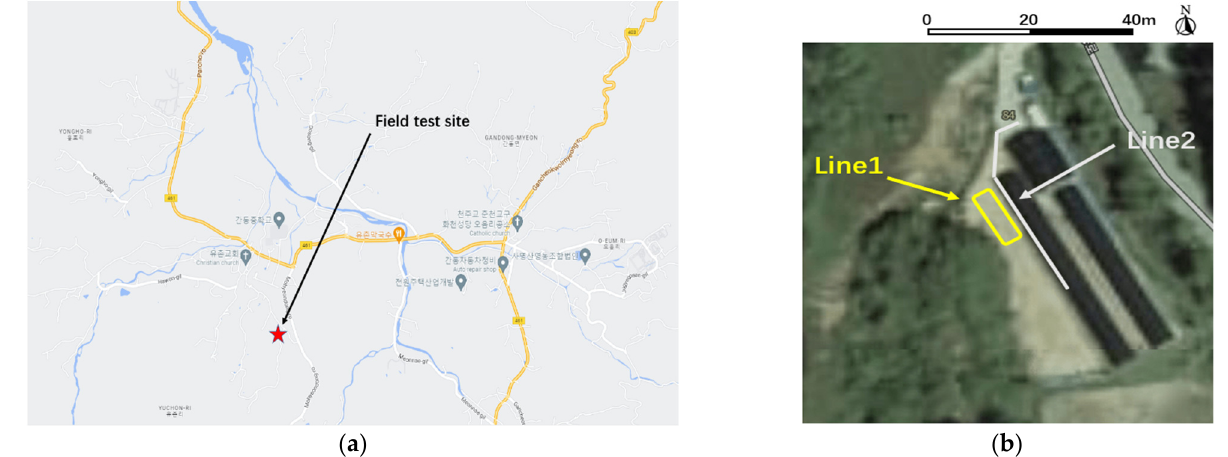
Figure 10. Details of field test site: ( a ) location of field experiment site, ( b ) two test lines in the field test.